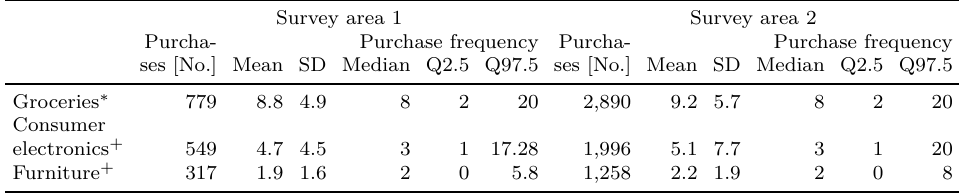
Table 5: Observed purchases and purchase frequency by survey area and retail sector Survey area 1 Survey area 2